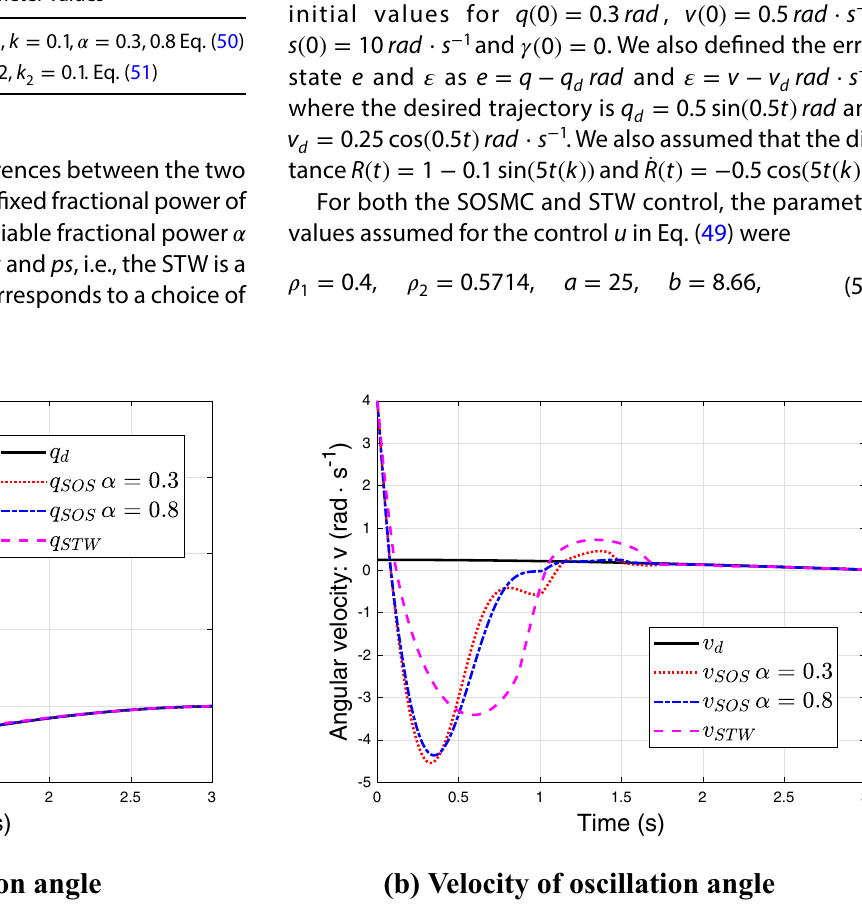
Table 1 Parameter values for the SOSMC and STW controllers Method Parameter values